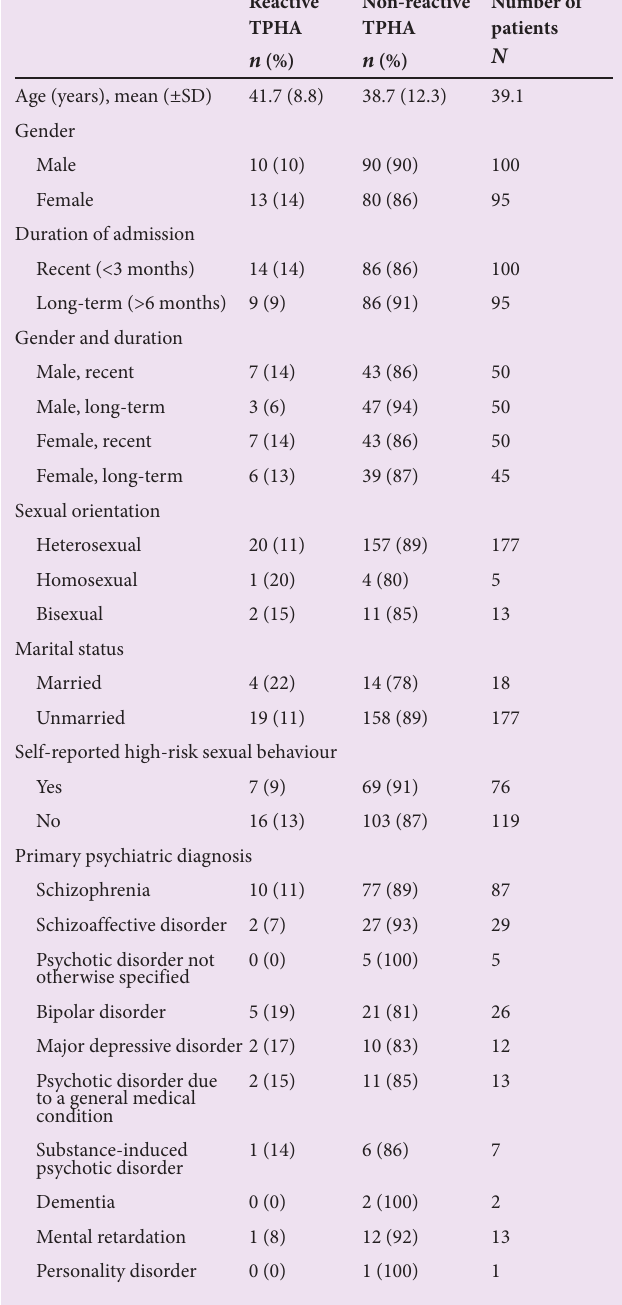
Table 2. Demographics, general characteristics, psychiatric diag- noses and syphilis serological reactivity